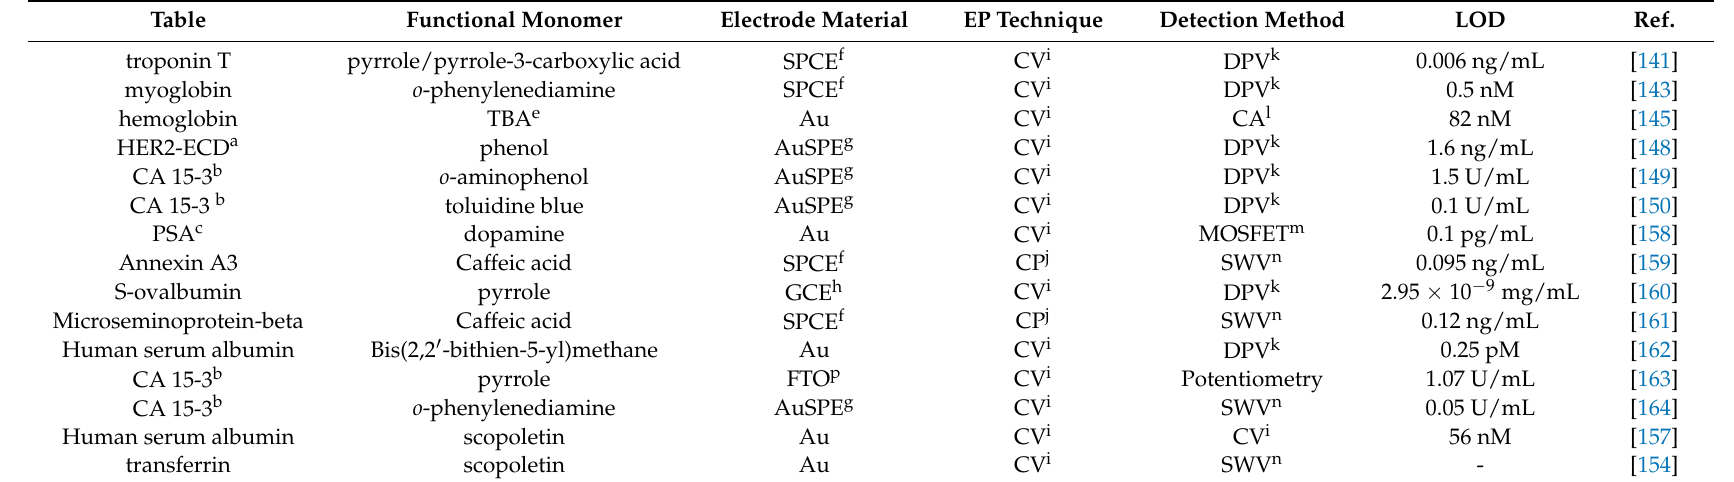
Table 4. Summary of recent publications for the detection of proteins using eMIPs. Includes information on the functional monomer used, electrode material, polymerization technique, detection method, and LOD. Table Functional